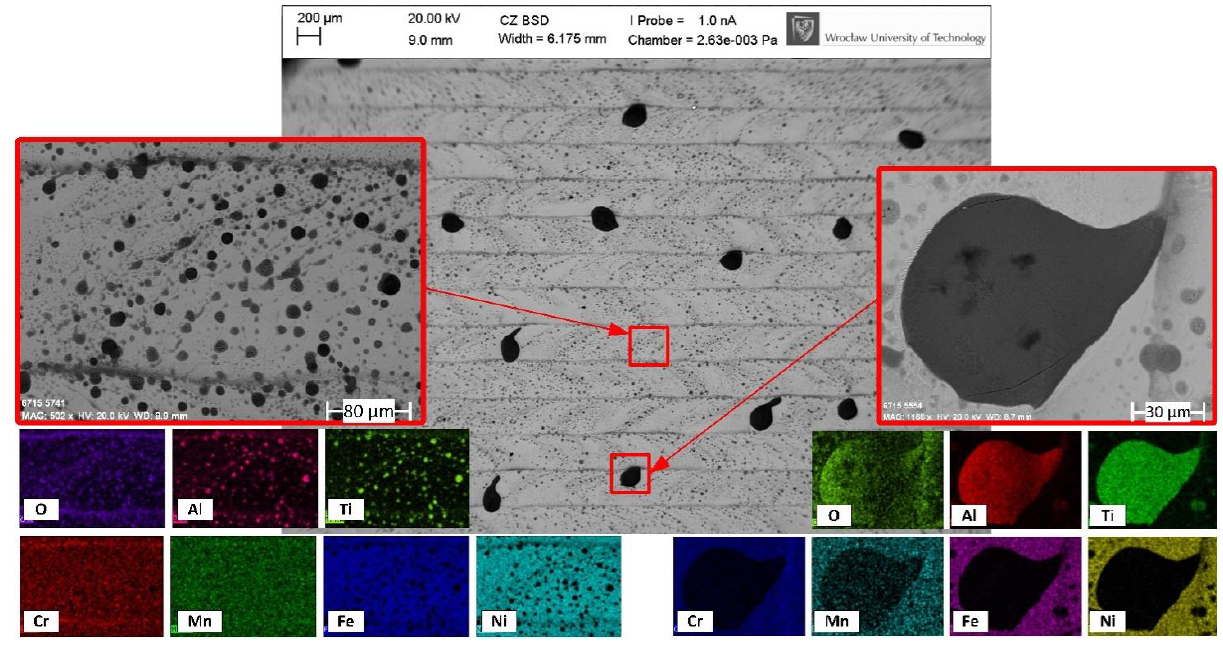
Figure 5. Back-scattered electron graph and EDS mapping showing the top-view and chemical elements of the sample (1.o) polished with 50% overlap in the air atmosphere.